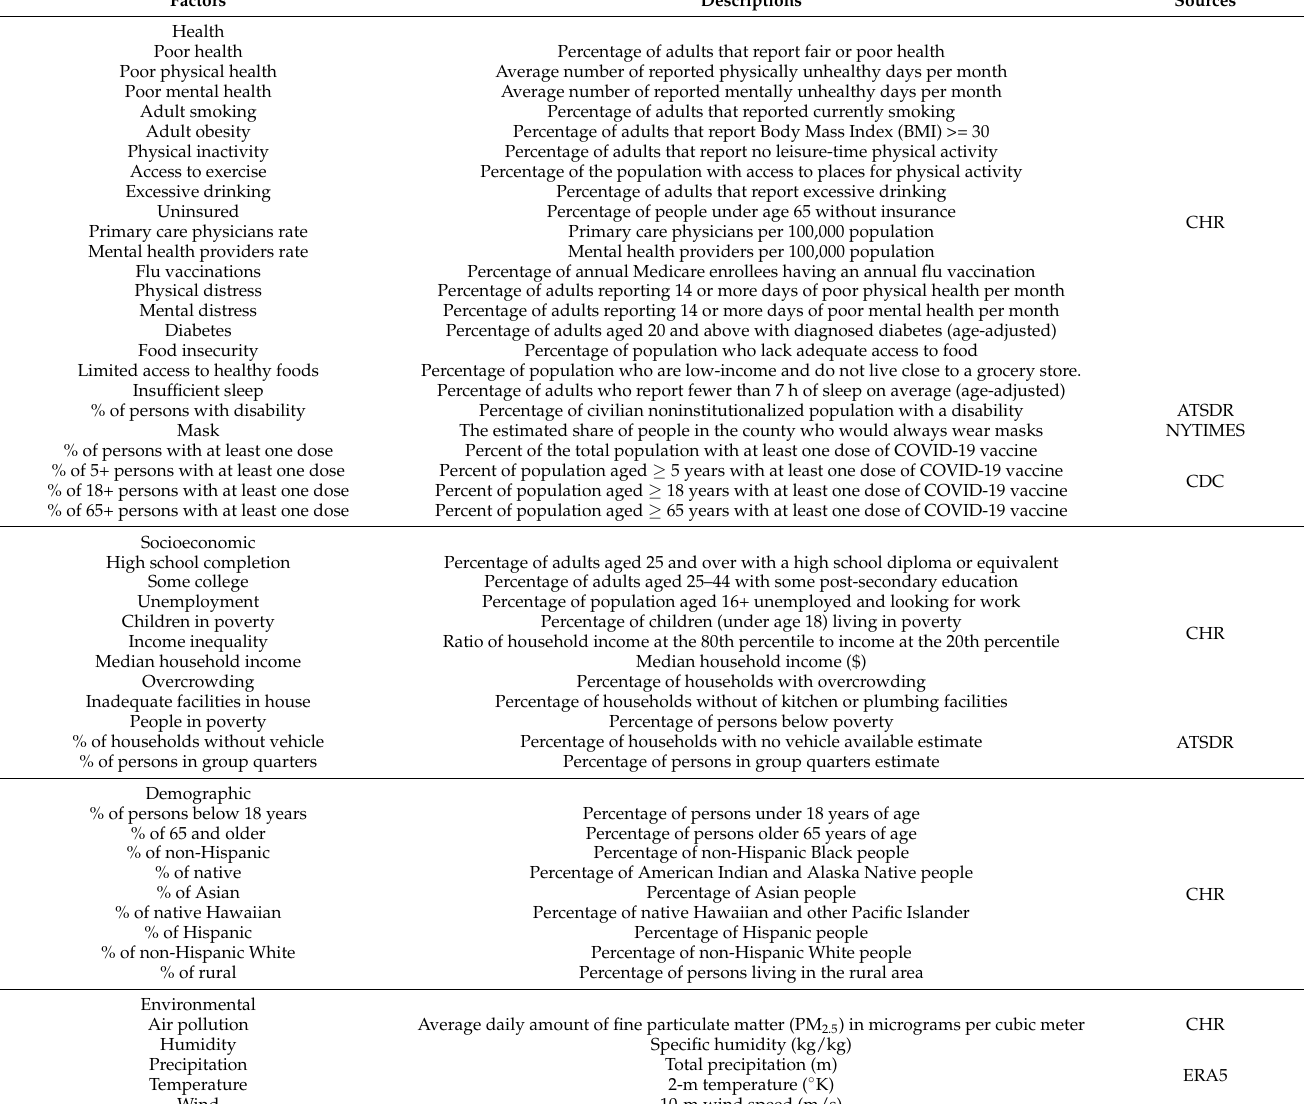
Table 2. Please note, to be concise, all the factor names in the following context refer to the names in the Column of ‘Factors’ in Table 2. Table 2. Descriptions and data sources of the health, socioeconomic, demographic, and environmental